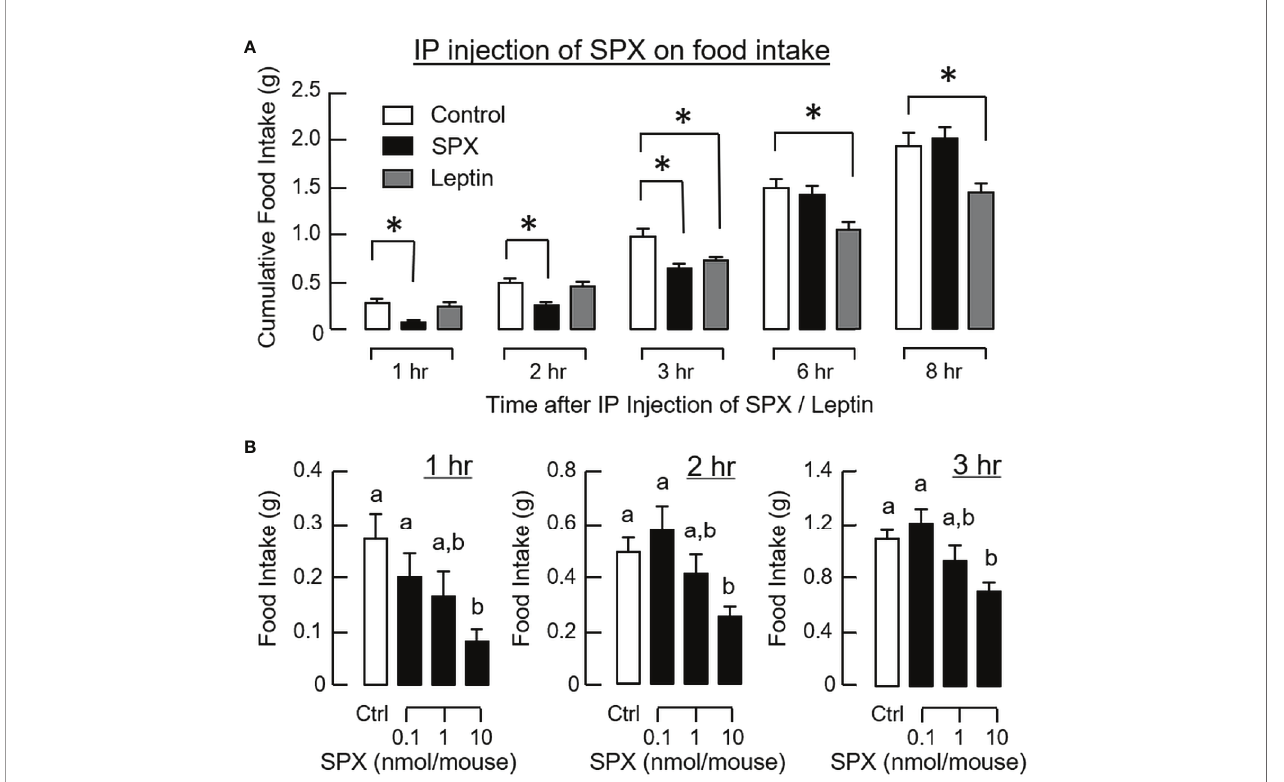
FIGURE 3 | Peripheral administration of SPX on food intake in mice. Time course (A) and dose dependence (B) of SPX treatment by IP injection (5 µl/g BW, injected at 10:00 AM ) on food consumption in mice. For time course study, SPX was tested at a dose of 10 nmol/mouse to examine its effects on food intake up to 8 h. For dose dependence, the corresponding effects of increasing levels of SPX (0.1-10 nmol/mouse) were monitored for 1, 2, and 3 h, respectively. IP injection with physiological saline was used as the control treatment and parallel injection with leptin (10 nmol/mouse) was conducted to serve as a positive control. The groups denoted by asterisks (*)/different letters represent a signi fi cant difference at p <